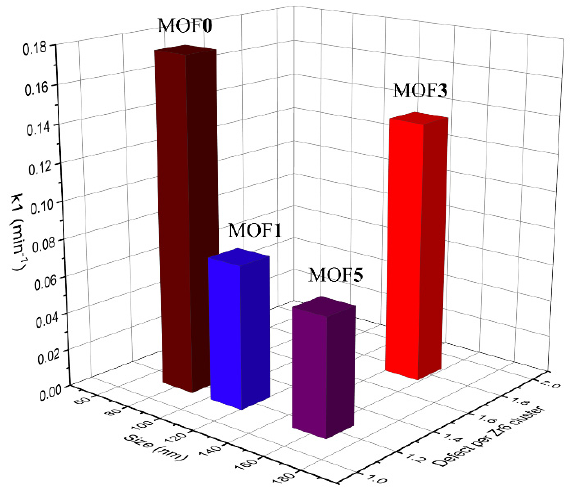
Figure 7. The three-dimensional relationship diagram of the first-order chemical reaction rate constant (k 1 ) with the sizes of the MOF catalysts and their defect degrees.